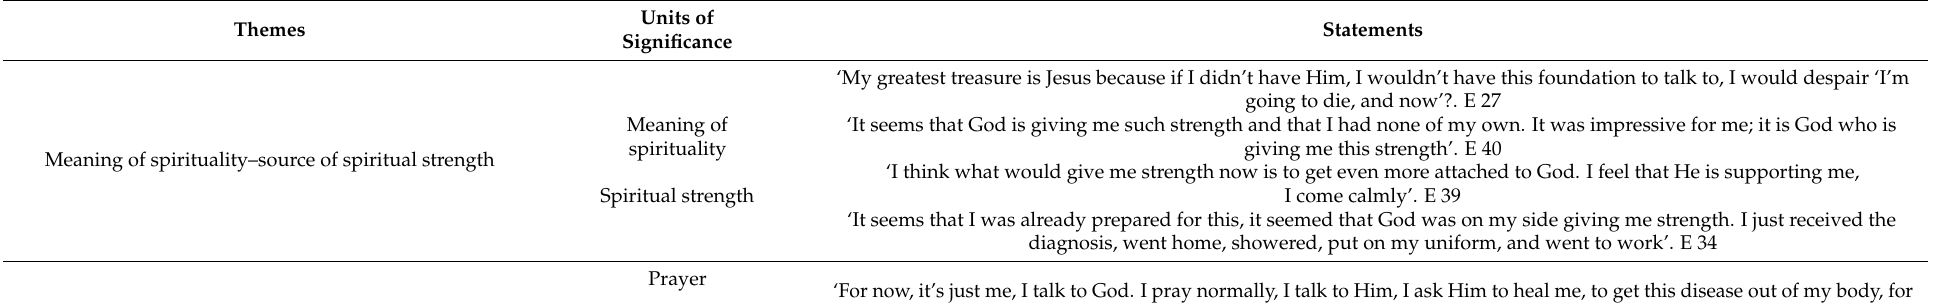
Table 2. Themes and statements of the